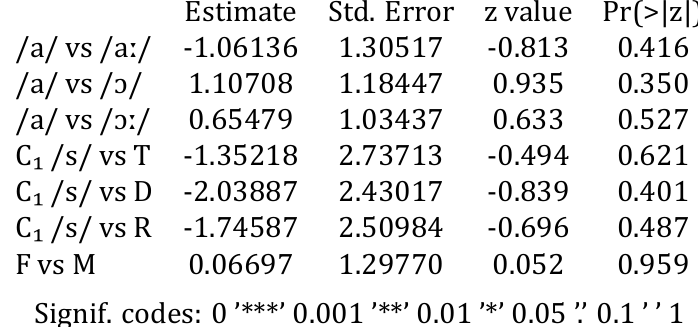
Table A.12: Pre-aspiration occurrence of C₂ /s/ as a dependent vari-